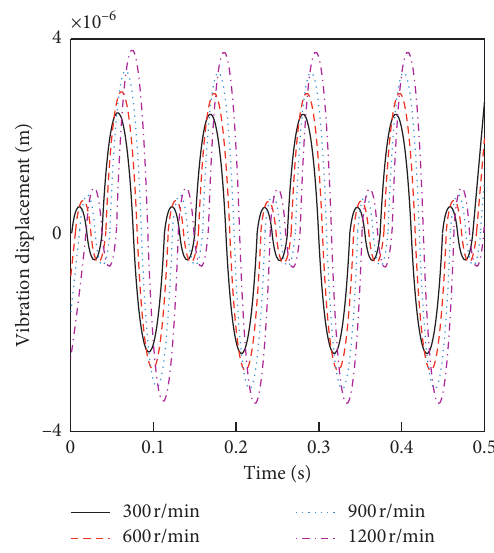
Figure 7: Variation law of axial displacement of spindle at different speeds.